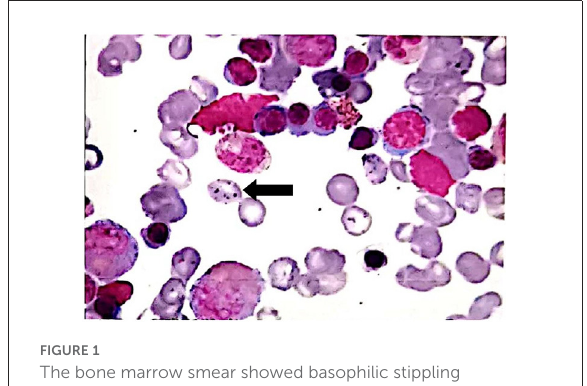
FIGURE1 The bone marrow smear showed basophilic stippling erythrocyte